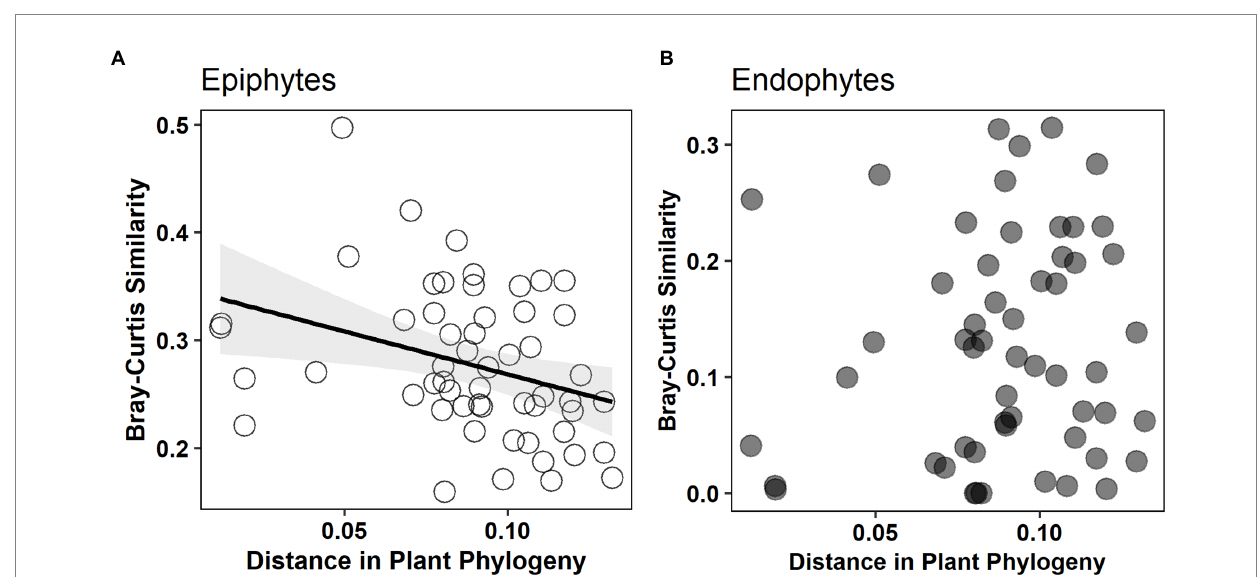
FIGURE 4 The relationship between Bray–Curtis similarity of epiphytic and endophytic fungal community and distance in plant phylogeny. Significant negative relation [ (A) Mantel r = − 0.332, p = 0.032] is shown for epiphytes but not for endophytes [ (B) Mantel r = 0.099, p = 0.658].